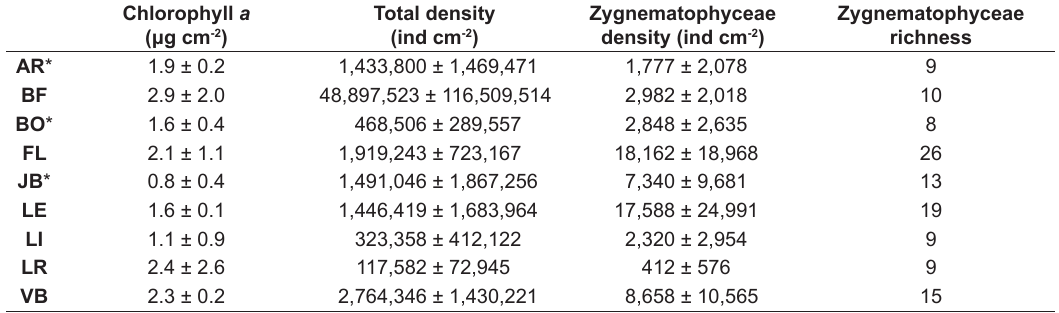
Table 3. Mean and standard deviations (n = 6, except at AR, BO and JB, where n = 3) values for periphyton community structure in nine urban eutrophic ponds from Goiânia, GO (see codes at Table